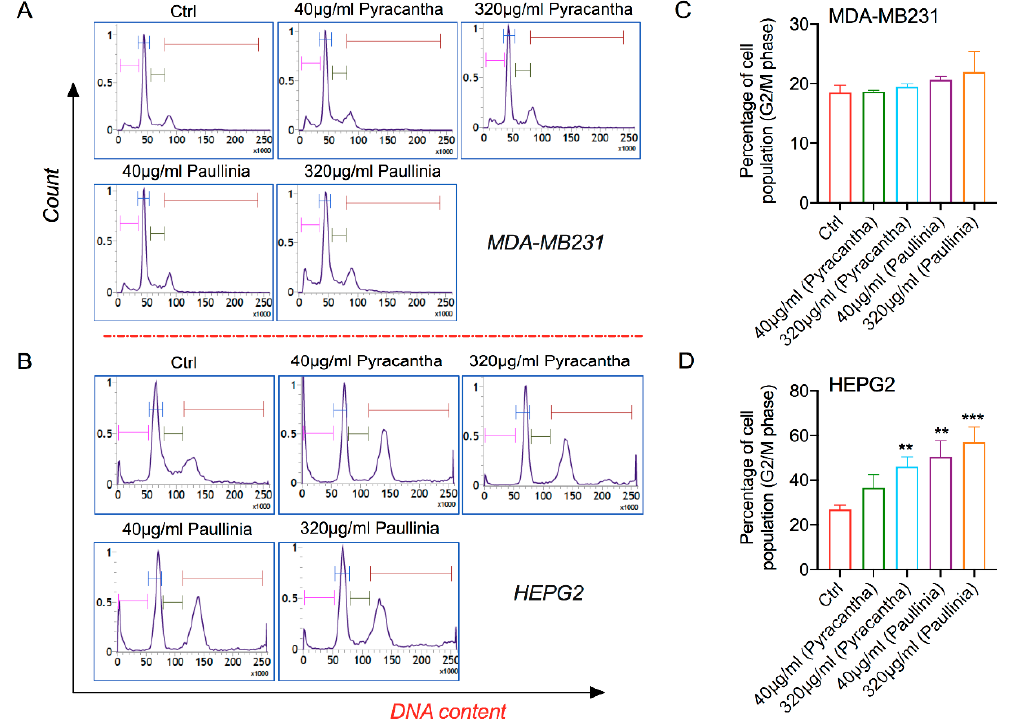
Figure 6. Pyracantha and Paullinia stimulate cell cycle arrest in both cancer cell types. ( A and B ) PI/RNase A-stained cells treated with two different concentrations (40 or 320 µg ∙ mL –1 ) of Pyracantha and Paullinia were analyzed using flow cytometry. The cell populations are marked as sub-G1 (pink), G0/G1 (blue), S (green), and G2/M (brown) in histograms. ( C and D ) The representative graph shows the percentage of the cell population in the G2/M phase in MDA-MB231 and HEPG2 cancer cells, respectively. Untreated samples were used as controls for all tested plant extracts.